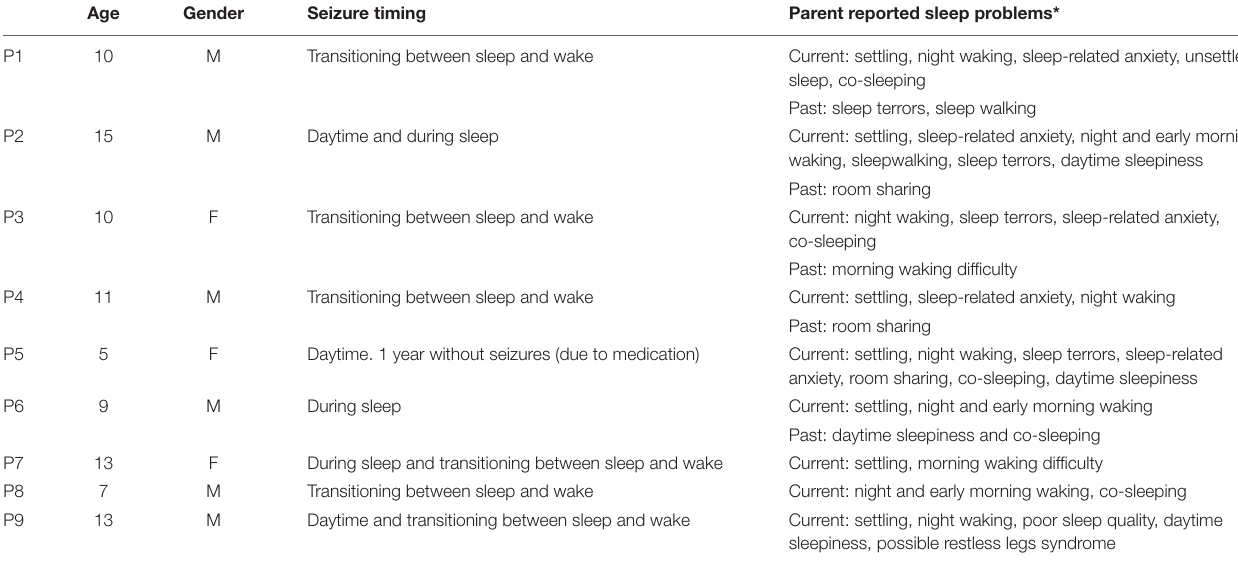
TABLE 1 | Descriptive information about children of the